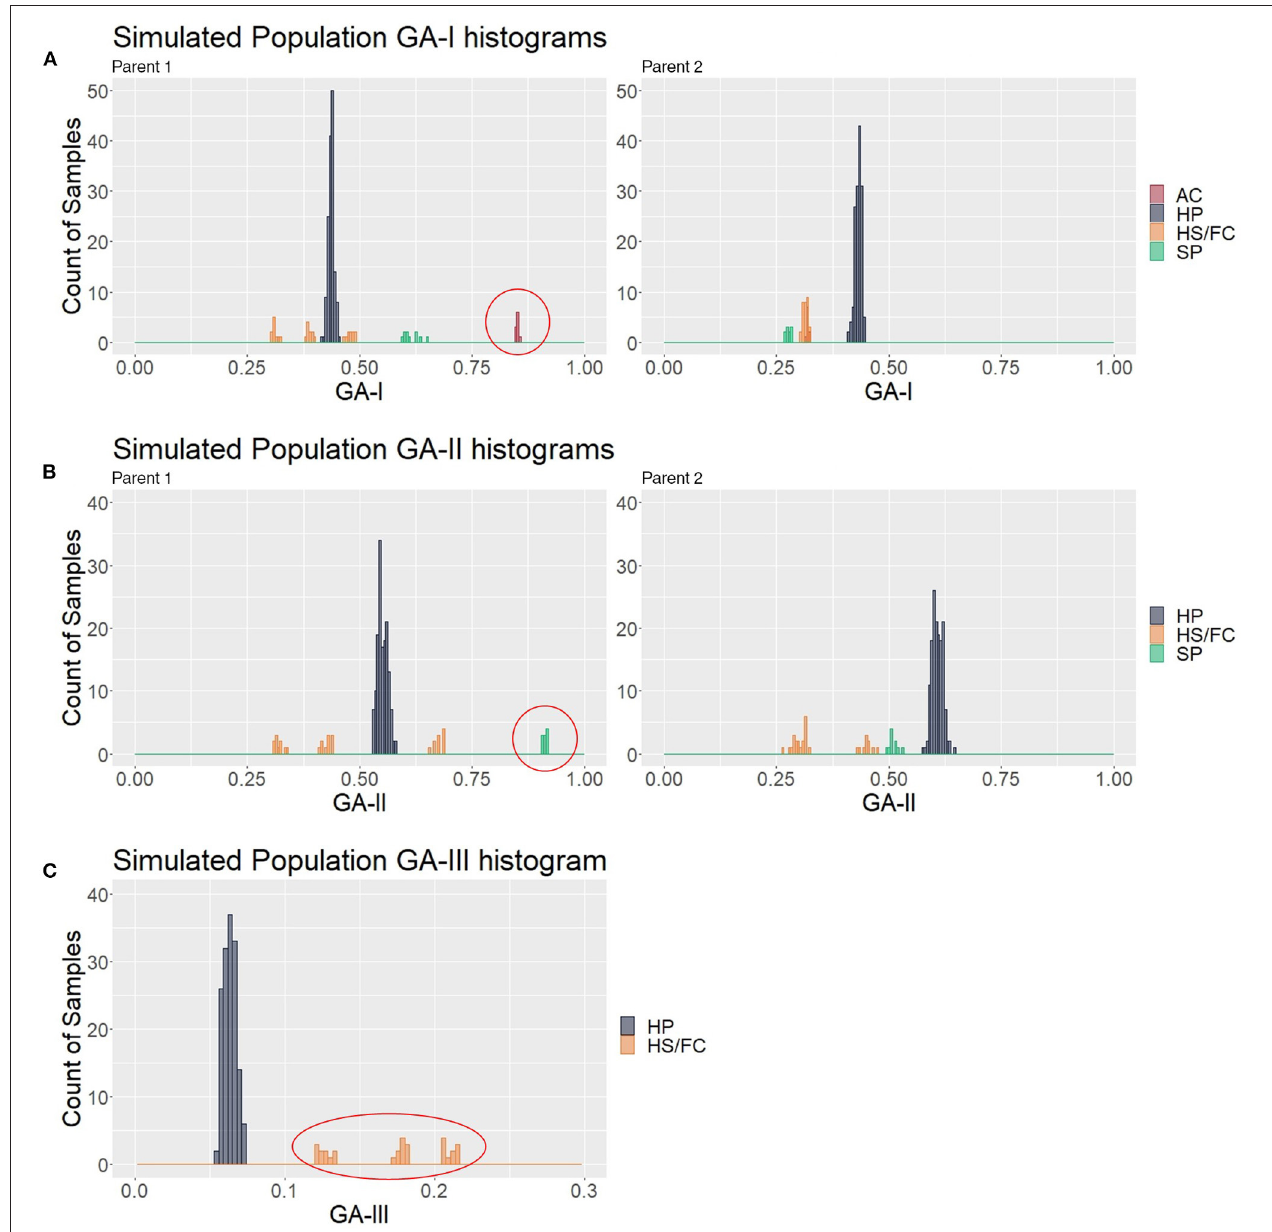
FIGURE 4 | Genotype analysis (GA)-based histograms of the simulated population with samples classified in the clustering analyses (CAs). (A–C) show the results from GA-I, GA-II, and GA-III, respectively. Red circles highlight the identified contaminants, i.e., apomictic clones (AC), self-progeny (SP), and half siblings/full contaminants (HSs/FCs), in contrast to the hybrid progeny (HP).